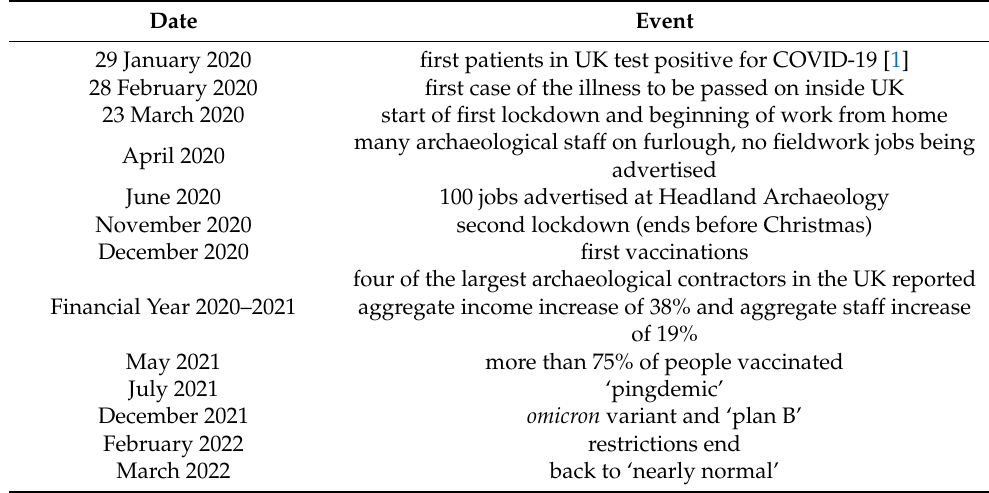
Table 1. Timeline of Coronavirus COVID-19 and archaeology in the United